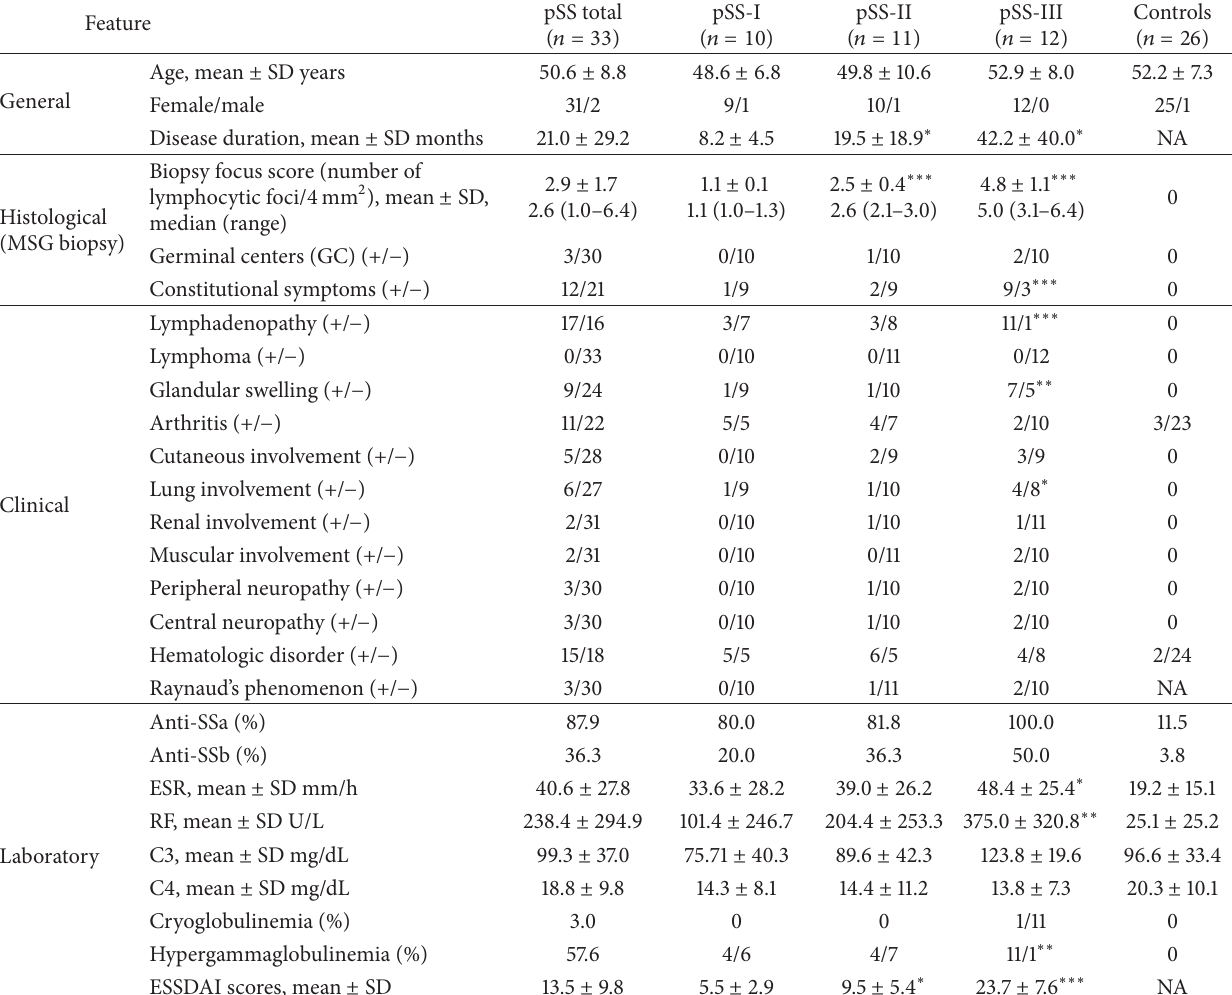
Table 1: Characteristics of the pSS patients included in the